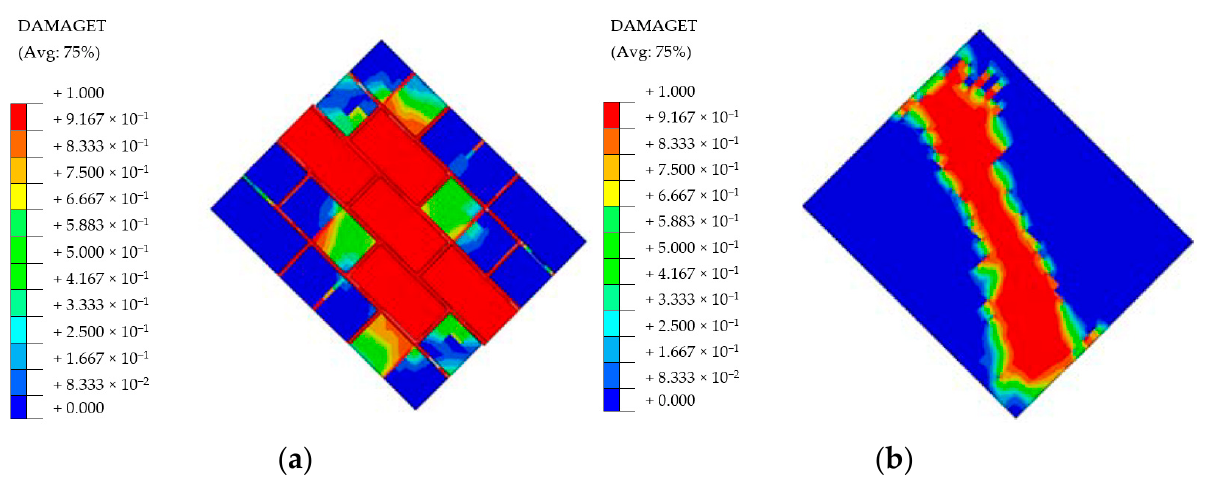
Figure 16. Damage distribution on the ( a ) micro-modeled wallet and ( b ) macro-modeled wallet.